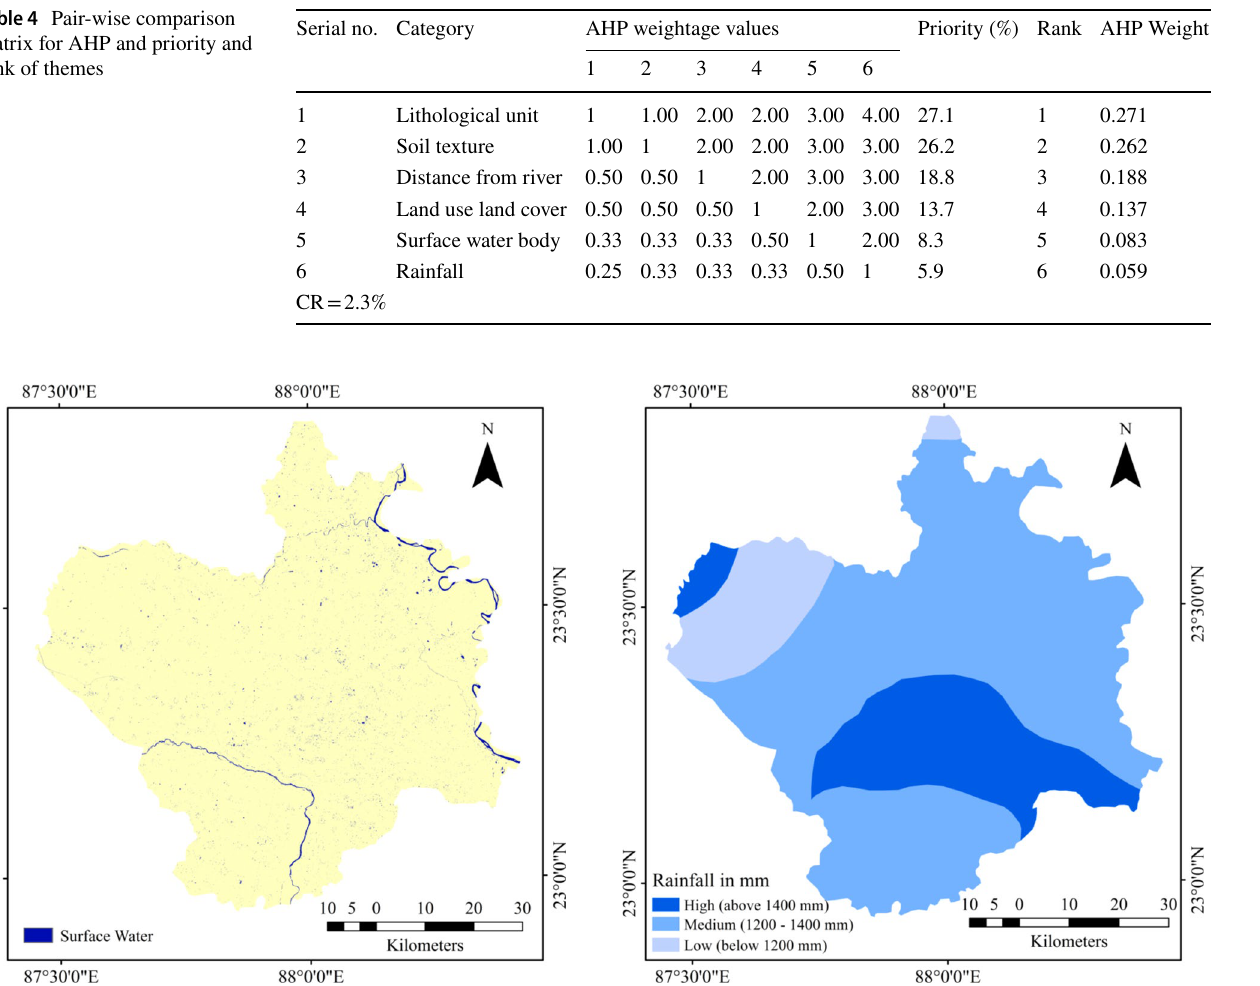
Fig. 7 Surface water map Fig. 8 Rainfall distribution